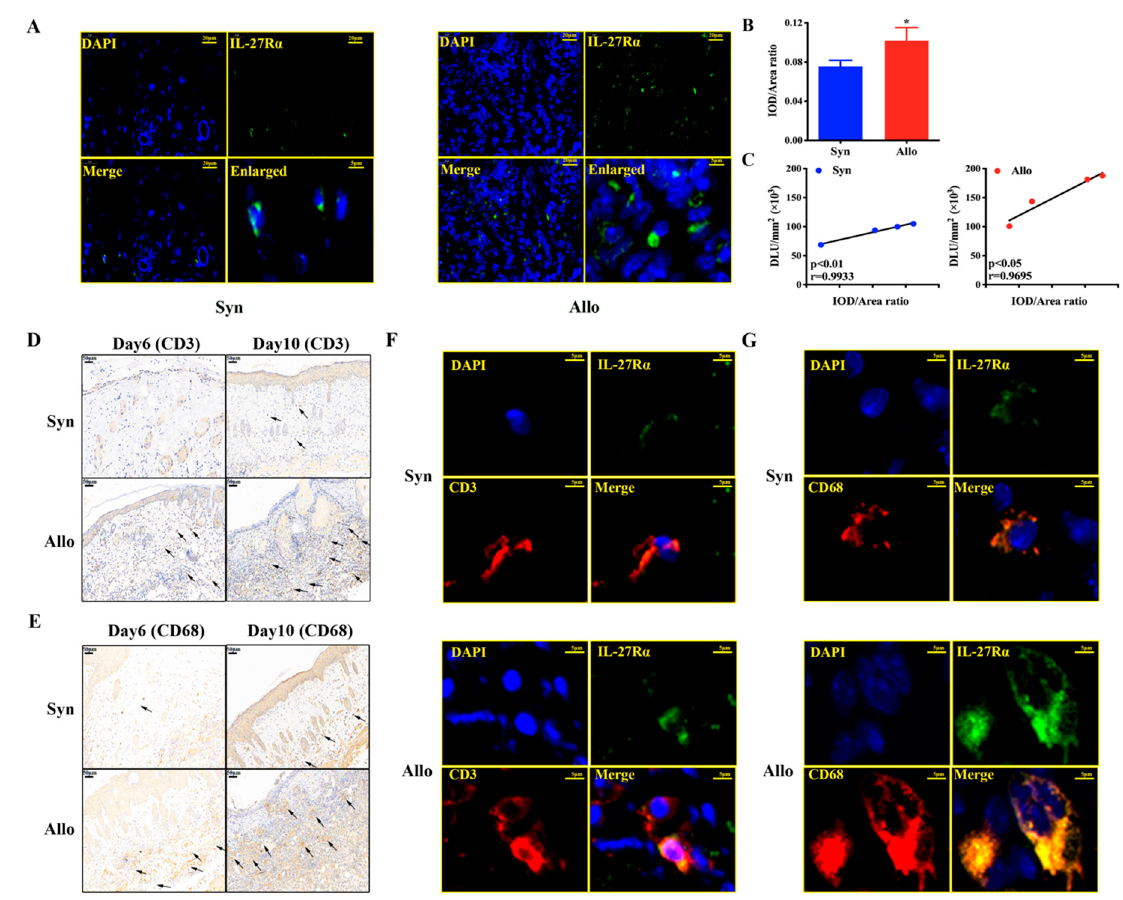
Figure 7. The relationship of in vivo radioactivity accumulation ( 125 I-anti-IL-27R α mAb) with IL-27R α positive cells. Skin transplantation mice models were established and the graft was isolated. ( A ). The IL-27R α staining (green) was performed for the graft on day 10 post transplantation, and the cell nucleus was stained with DAPI (blue). ( B ). The IL-27R α expression (green) was analyzed and represented by the IOD/Area ratio. ( C ). Correlation between graft radioactivity uptake (DLU/mm 2 ) and IL-27 R α expression (IOD/Area ratio) on day 10. ( D , E ). CD3 ( D ) and CD68 ( E ) staining of graft on day 6 and day 10 post transplantation. ( F , G ). The IL-27R α (green) expressed on the CD3 ( F ) and CD68 ( G ) positive cells of the graft on day 10 post transplantation . * p < 0.05 vs. syngeneic group. Scale bar 20 μ m (A), 50 μ m (D,E), 5 μ m (F,G).